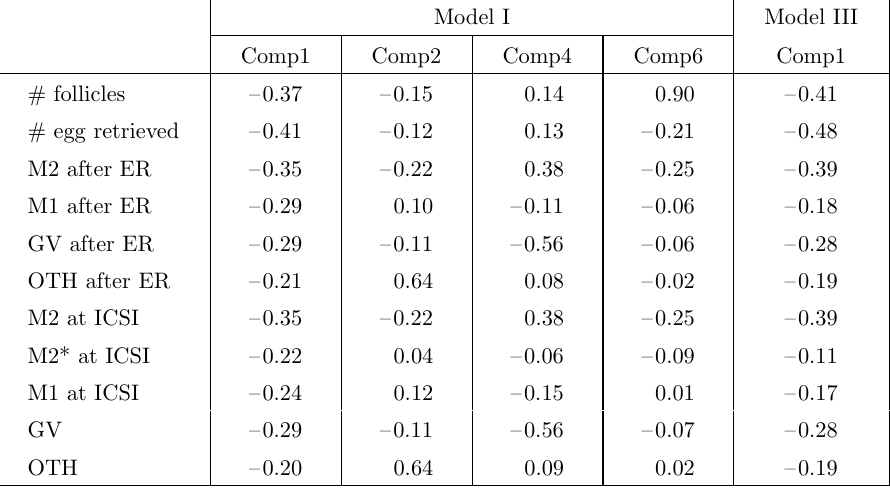
Table 3. Selected components obtained with the PCA method for the I and III